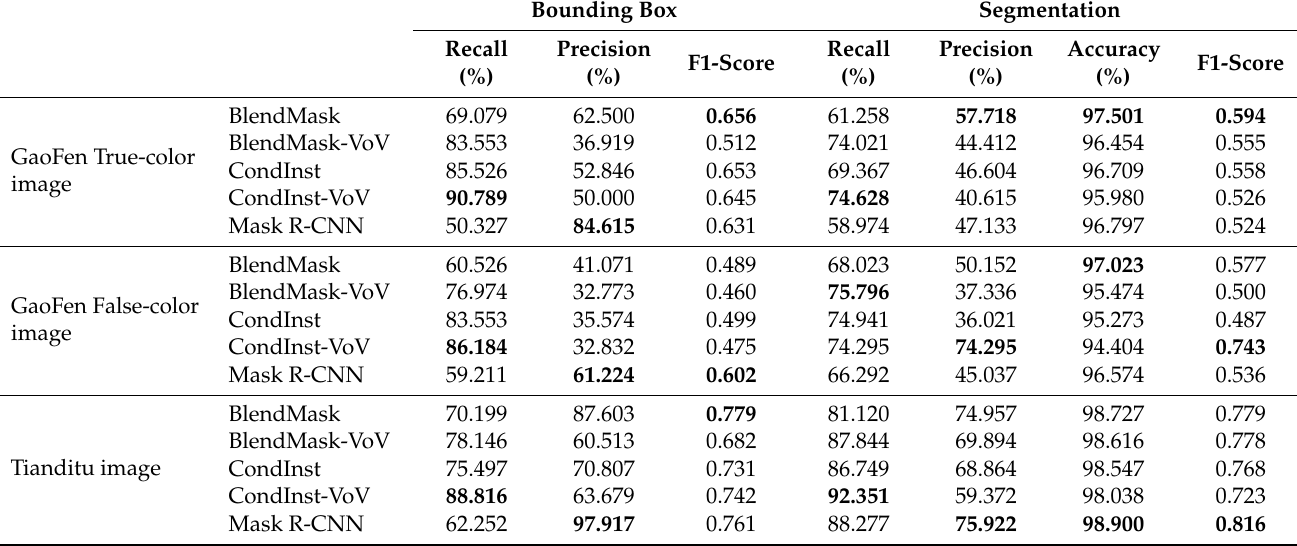
Table 6. Quantitative Evaluation of model inference results in Daye Town. Bounding